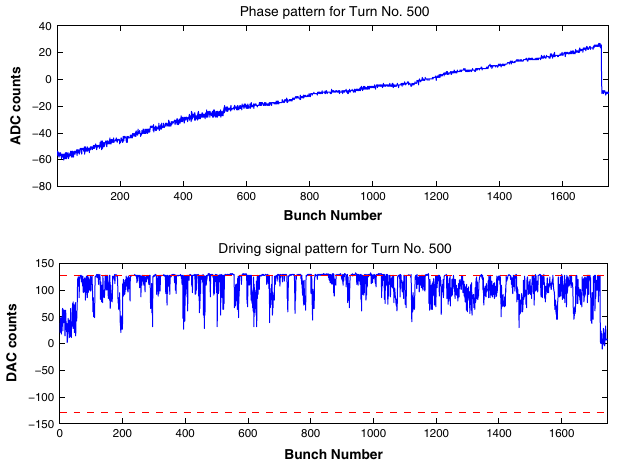
FIG. 10. (Color) Front-end and back-end signal of the HER longitudinal feedback system for turn 500. The upper plot shows the phase error signal for all the bunches. The lower plot depicts the base band signal driving all the individual bunches at the same turn. Figures 11–14 show the same signal for turns 502 to 512 corresponding to half a period of the approximately 6 kHz synchrotron oscillation. At this moment the kick signal is almost completely saturated at the full-scale value of þ 127 .